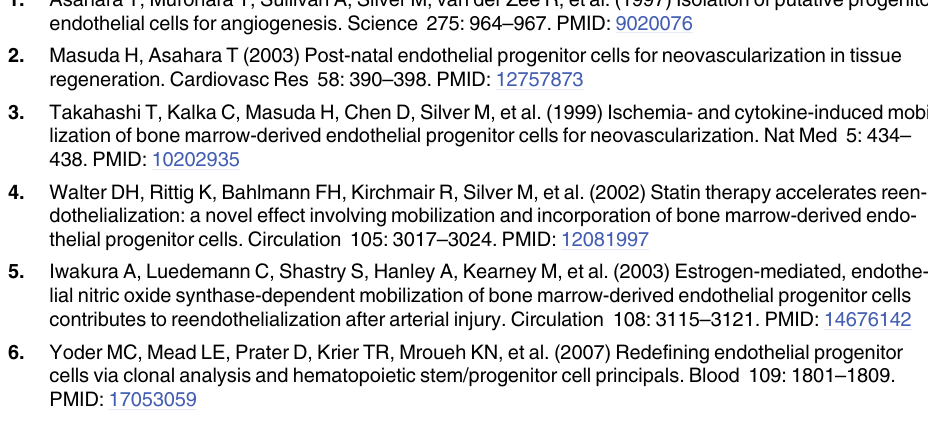
S4 Fig. EBs morphologies and staining after 7 days of differentiation. (A) EBs formation after 7 days in ultra-low attachment dish and after 7 days on gelatin with the different mor- phologies of cells. Scale bars represent 100 μ m. (B) Immunostaining of iPSC-derived embryoid bodies: Expression of ectodermal ( β III tubulin, nestin), endodermal (AFP, HNF-3 β ) and meso- dermal (CD31, SMA) derivatives. Scale bars represent 50 μ m. S5 Fig. CB-ECFCs phenotype. Representative Flow cytometry analysis of the positive endo- thelial markers CD31, CD144 and KDR (A) and of the negative hematopoetic/monocytic markers CD45 and CD14 (B) (IgG isotopic control: black line, markers: red line). S1 Table. Accession numbers of TaqMan 1 (Applied Biosystems) assays used for quantita- tive-PCR. S2 Table. Primer sequences of endogenous, exogenous and endothelial genes used for SYBR